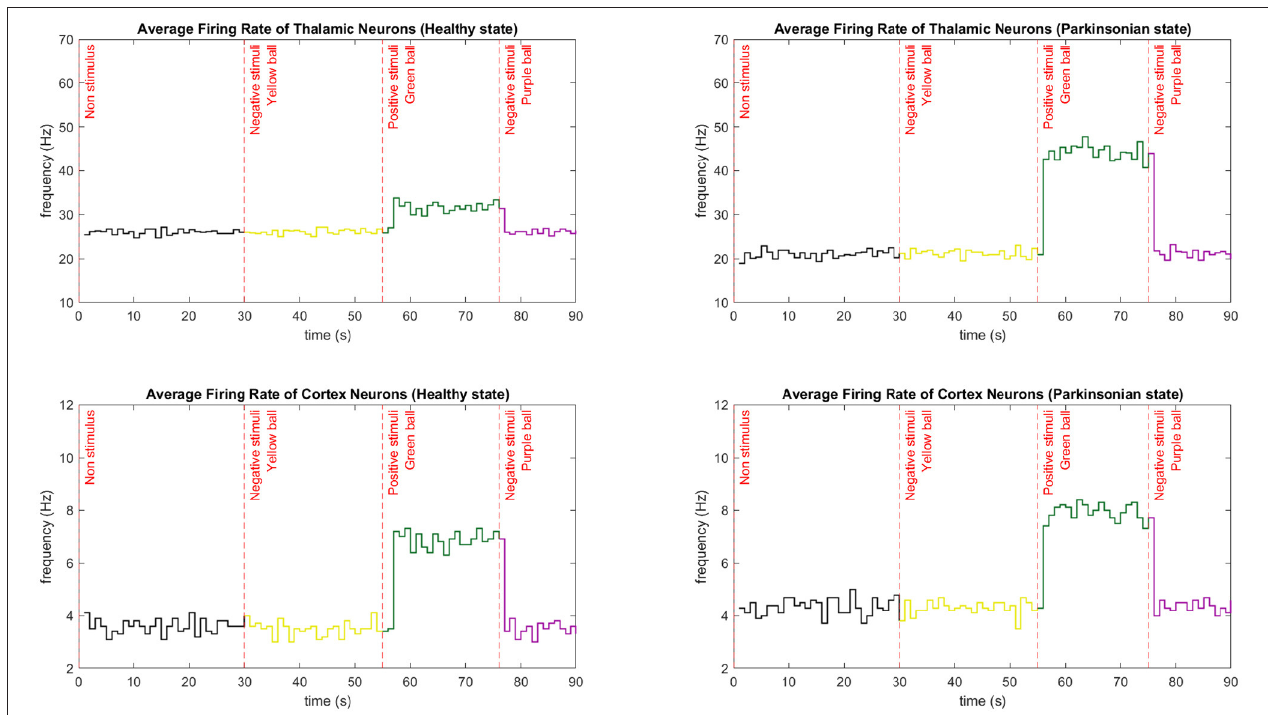
FIGURE 13 | Average firing rate comparison between neurons from CTX and TH during the performance of one entire task. The average firing rate is calculated every second by integrating the spikes from those regions and dividing it by the number of neurons. Three different stimuli were presented to the robot in different moments of the task. The sequence of the colour of the balls in both conditions were yellow (30 s), green (55 s), and purple (75 s). Each graphic shows the exact moment of the transition from a negative to a positive stimuli and vice versa. In those cases, the firing rate rapidly increases and decreases, respectively. The first stimulus maintain the low firing rate since it does not bring any curiosity for the robot. Note that thalamic neurons have a higher firing rate compared to cortical neurons.